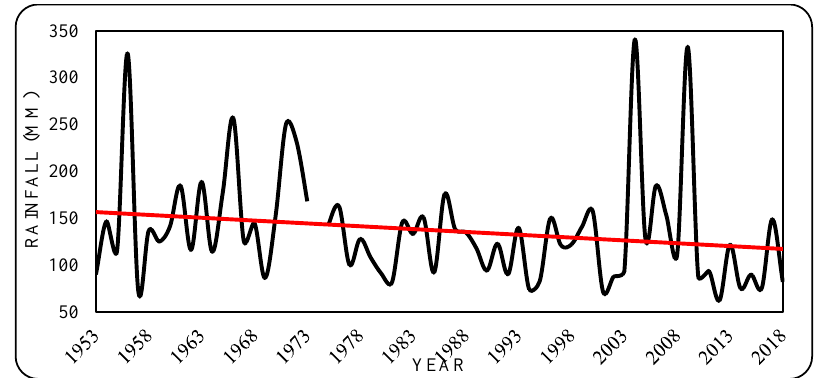
Figure 5. Annual daily maximum rainfall distribution in Dhaka during 1953–2018.